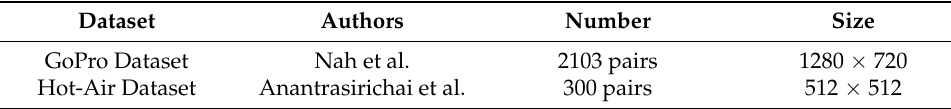
Table 2. The training datasets used in the article.